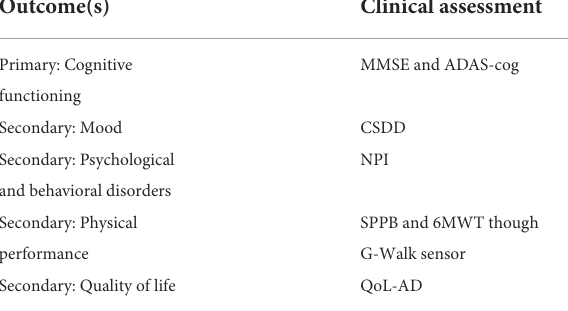
TABLE 2 Outcomes and clinical assessments. Outcome(s) Clinical